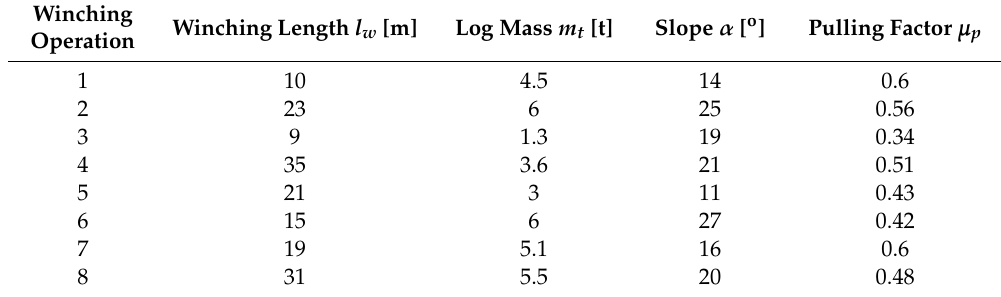
Table 6. Winching